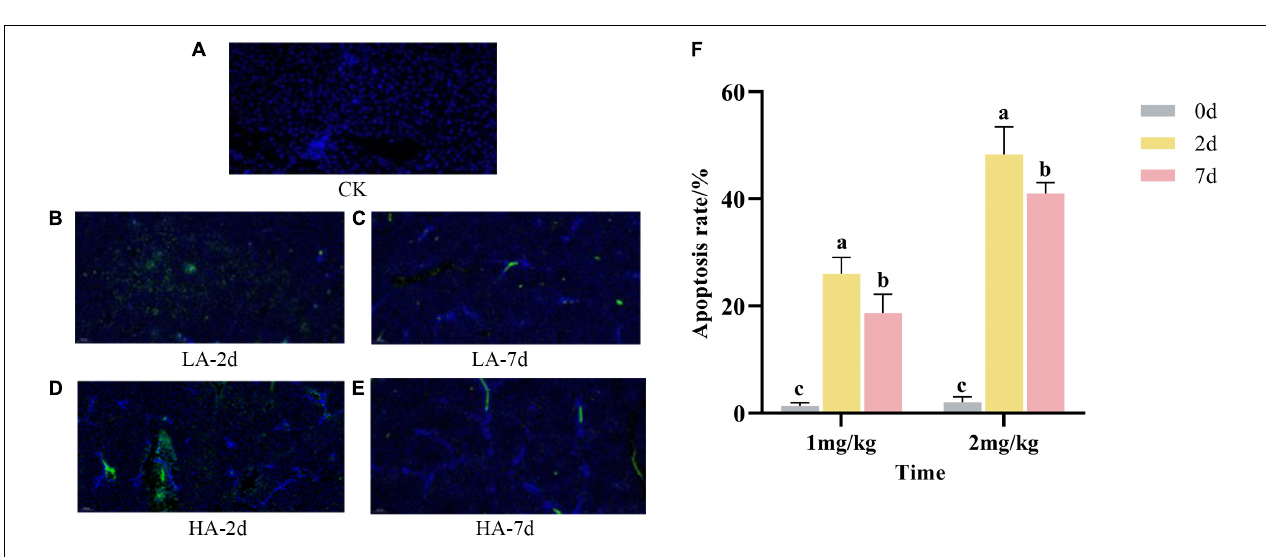
Frontiers in Microbiology |